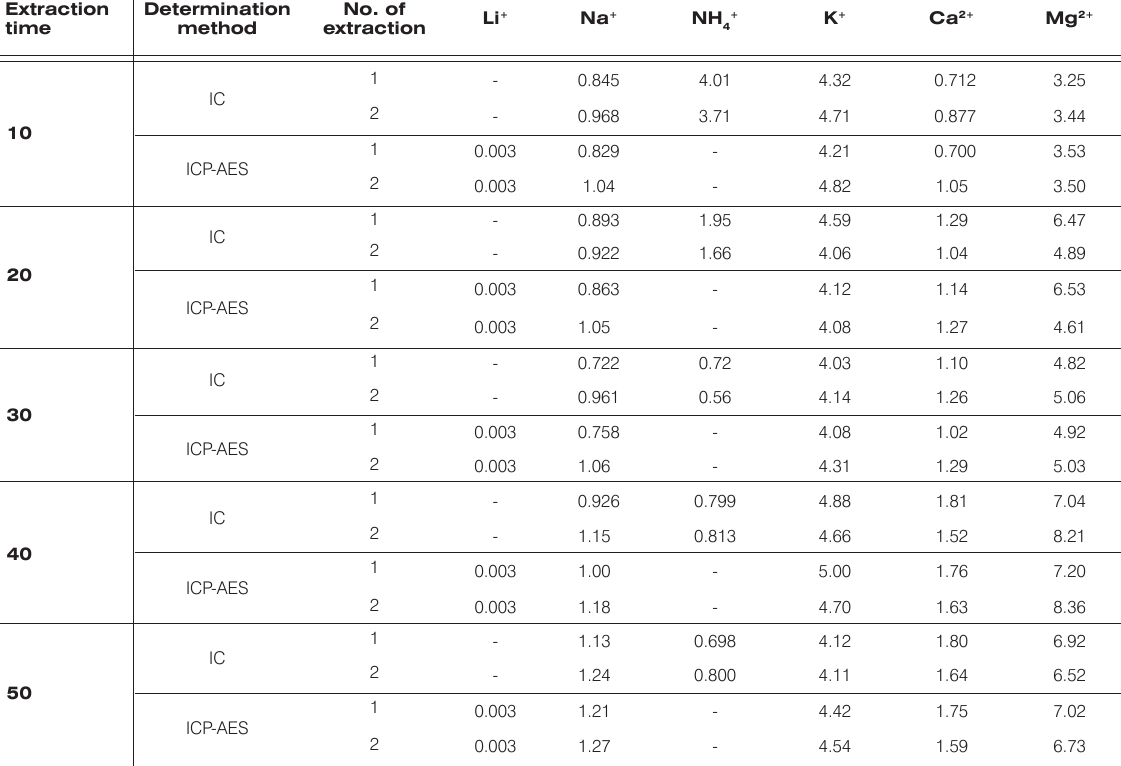
Table 5. The results of determinations of Li + , Na + , NH 4+ , K + , Ca 2+ and Mg 2+ ions obtained by IC and ICP-AES after UAE (mg/100 g soil). Extraction Determination time